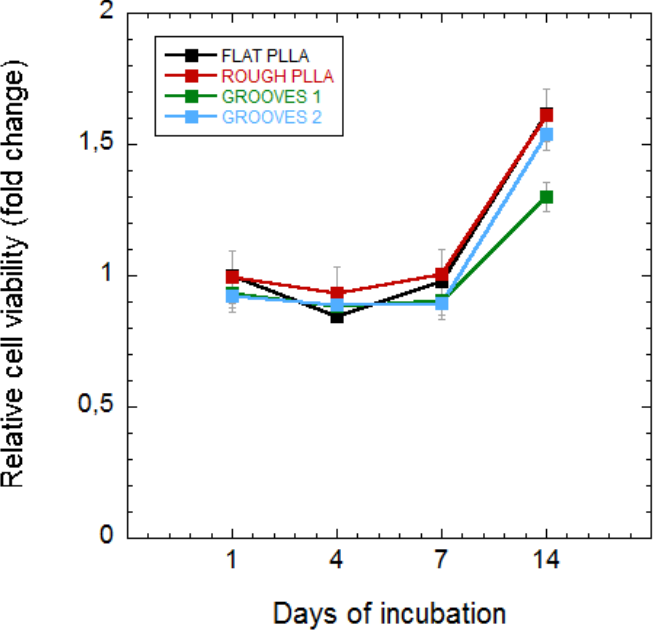
Figure 5. MSC proliferation (cells/cm 2 ), as quantified by MTT assays, on four types of surfaces and at different incubation times. Cell growth was normalized to the absorbance obtained with cells cultured on FLAT PLLA after one day of incubation, which was set as 1. The types of surfaces included: PLLA treated by laser to increase the surface roughness (ROUGH PLLA), and PLLA patterned by grooves of width = 10 µm, depth = 4 µm, and spacing = 15 µm (GROOVES 1) and 25 µm (GROOVES 2) in comparison with FLAT PLLA (b).